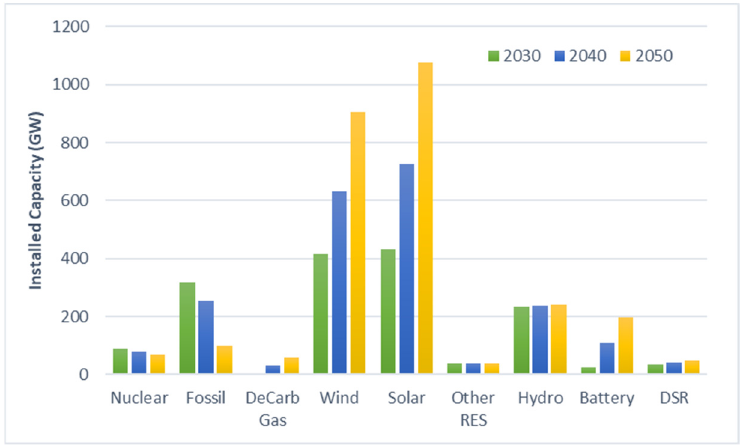
Figure 9. Distributed Energy (DE) scenario: evolution of installed capacities per technology, from 2030 to 2050.